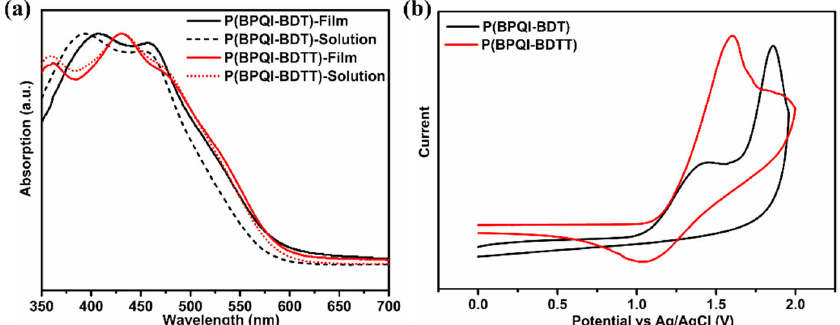
Figure 1. ( a ) Normalized UV ‐ vis absorption spectra of polymers P(BPQI ‐ BDT) and P(BPQI ‐ BDTT) in chloroform solution and as thin films. ( b ) Cyclic voltammogram curves of P(BPQI ‐ BDT) and P(BPQI ‐ BDTT) thin films measured in 0.1 M ( n ‐ Bu) 4 NPF 6 acetonitrile solution at a scan rate of 50 mV s − 1 . 50 mV s − 1 .